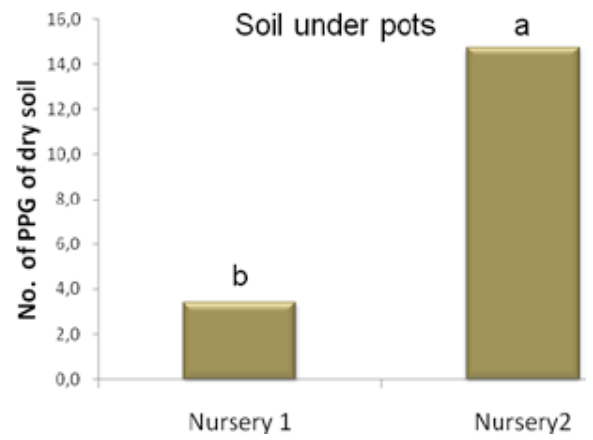
Figure 5. Average number of Phytophthora spp. prop- agules/gram (ppg) present in soil under the pots in the two monitored nurseries. Columns with different letters are statistically different according to Duncan’s multiple range test ( P